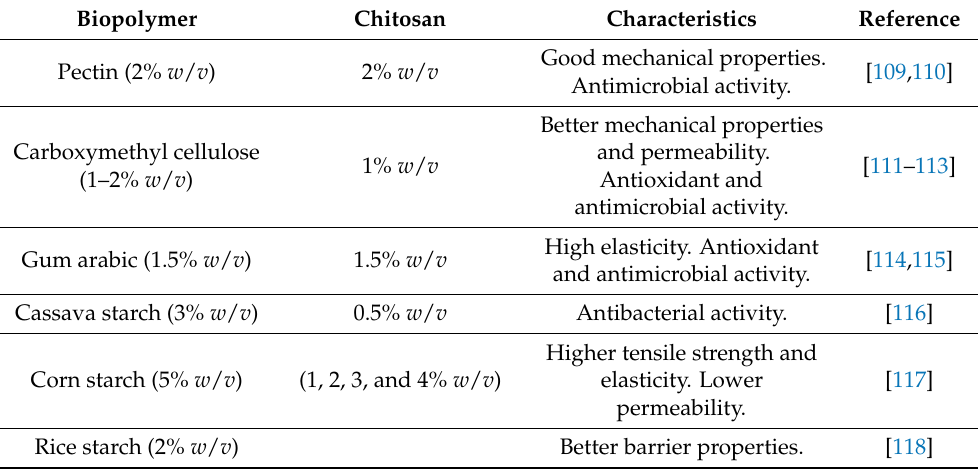
Table 4. Selection of blends of chitosan with other biopolymers for food packaging.